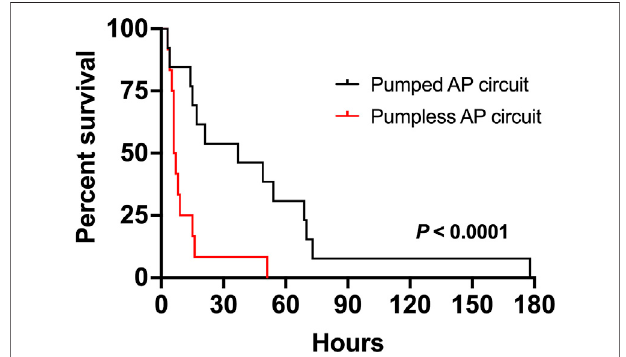
FIGURE 1 | Comparison of duration of support of fetal pigs supported on a pumped and pumpless (Charest-Pekeski et al., 2021) AP circuit. Fetal pigs maintained usingapumped APcircuit areshown asasolidblack line( n = 13), and fetuses supported using a pumpless circuit as the solid red line ( n =